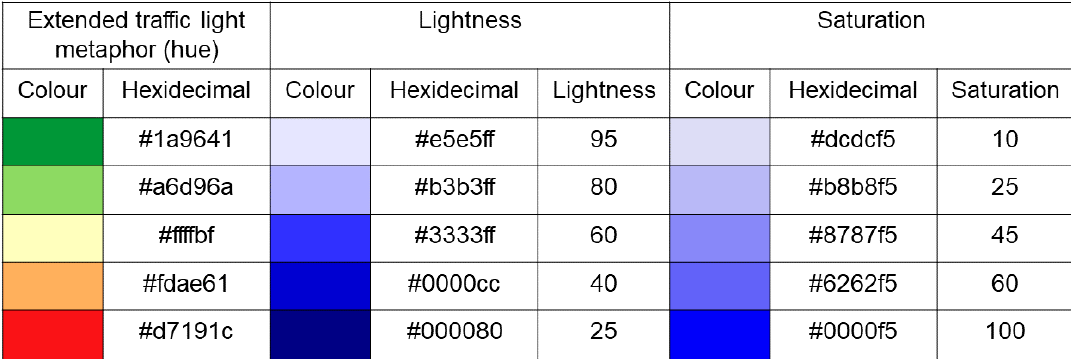
Figure 5. Colour scales for colour hue in the form of the extended traffic light metaphor, lightness, and saturation. Colours were optimised in ColorBrewer [95].